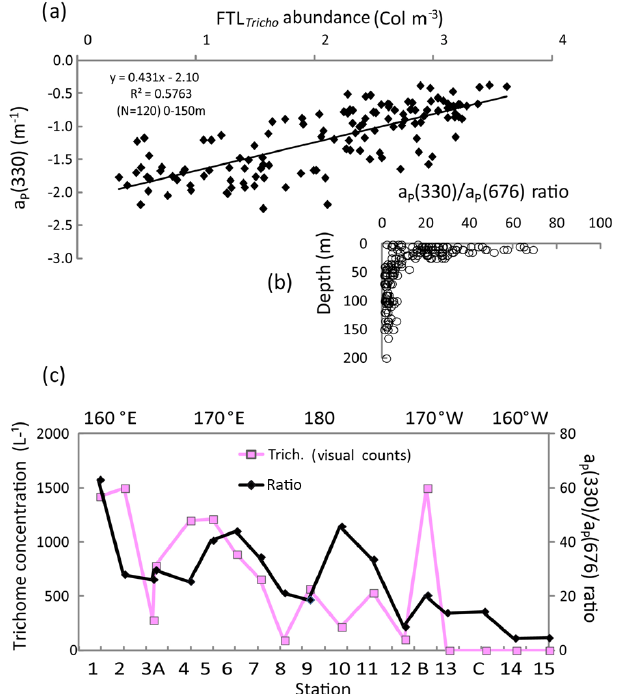
Figure 10. IOPs (continued): (a) relationship (log–log) between a P (330) and the UVP5 FTL Tricho abundance (coloniesm − 3 ) at all stations and depths (0–150m). (b) Vertical distributions of a P (330) /a P (676) at all stations, (c) OUTPACE surface values of the ratio a P (330) /a P (676) and trichome concentration (visual counts) along the transect. The x axis represents the station numbers (below) and the main longitudes (above).